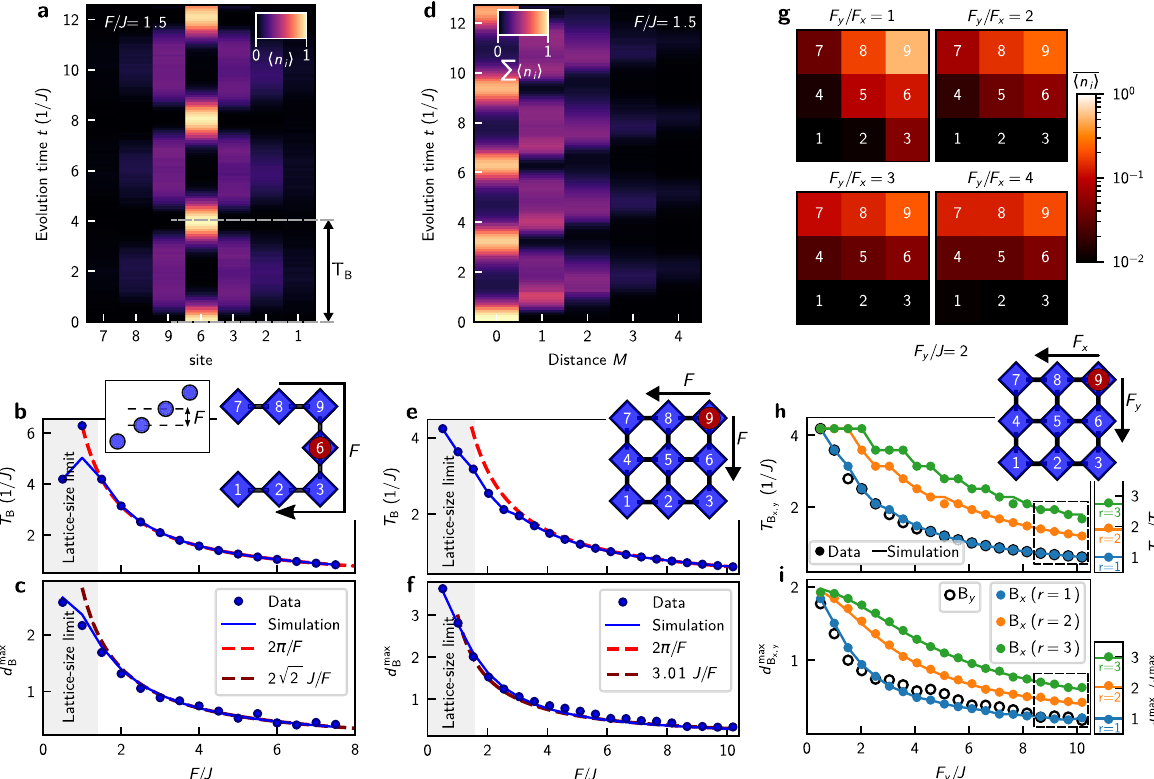
Fig. 4 Wannier-Stark localization. a Exemplary 1d Bloch oscillation with a particle initialized at the center of the lattice. The particle undergoes a spatially periodic breathing motion before re-converging at the initialization site. b , c 1d Bloch oscillation period T B and maximum particle spread d max